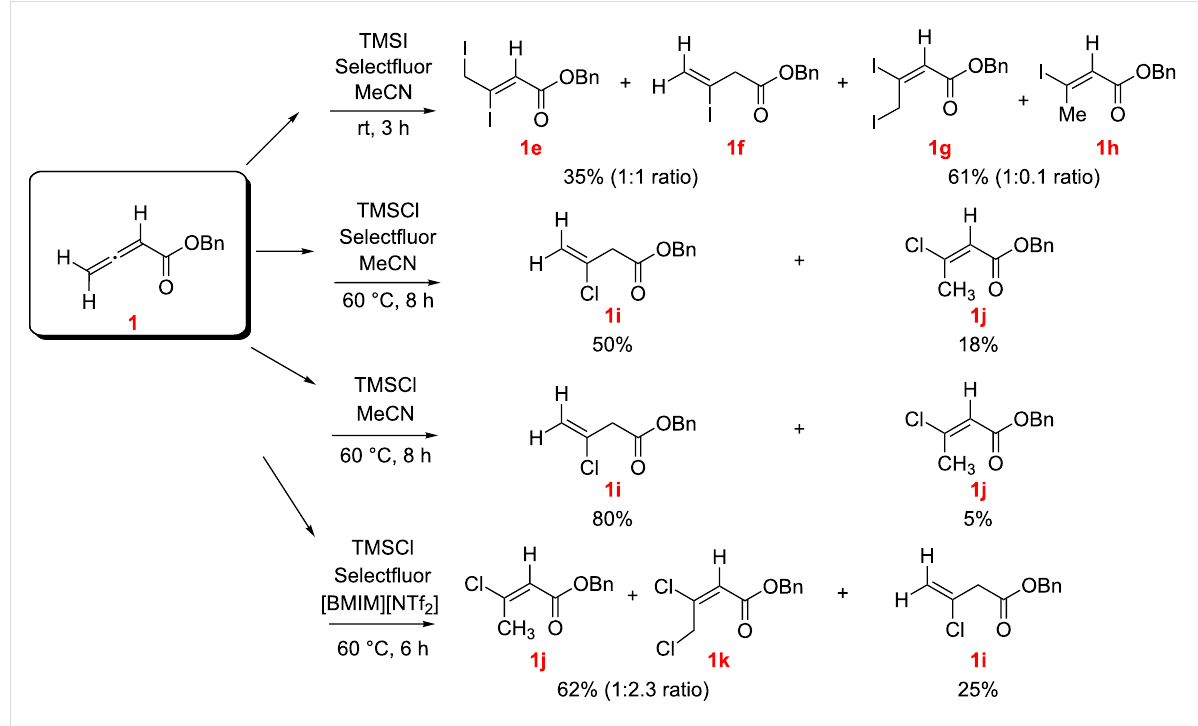
Scheme 3: Reaction of benzyl allenoate ( 1 ) with TMSI and TMSCl, with and without Selectfluor ( E/Z designations, as illustrated, were made by NMR; see Supporting Information File 1).